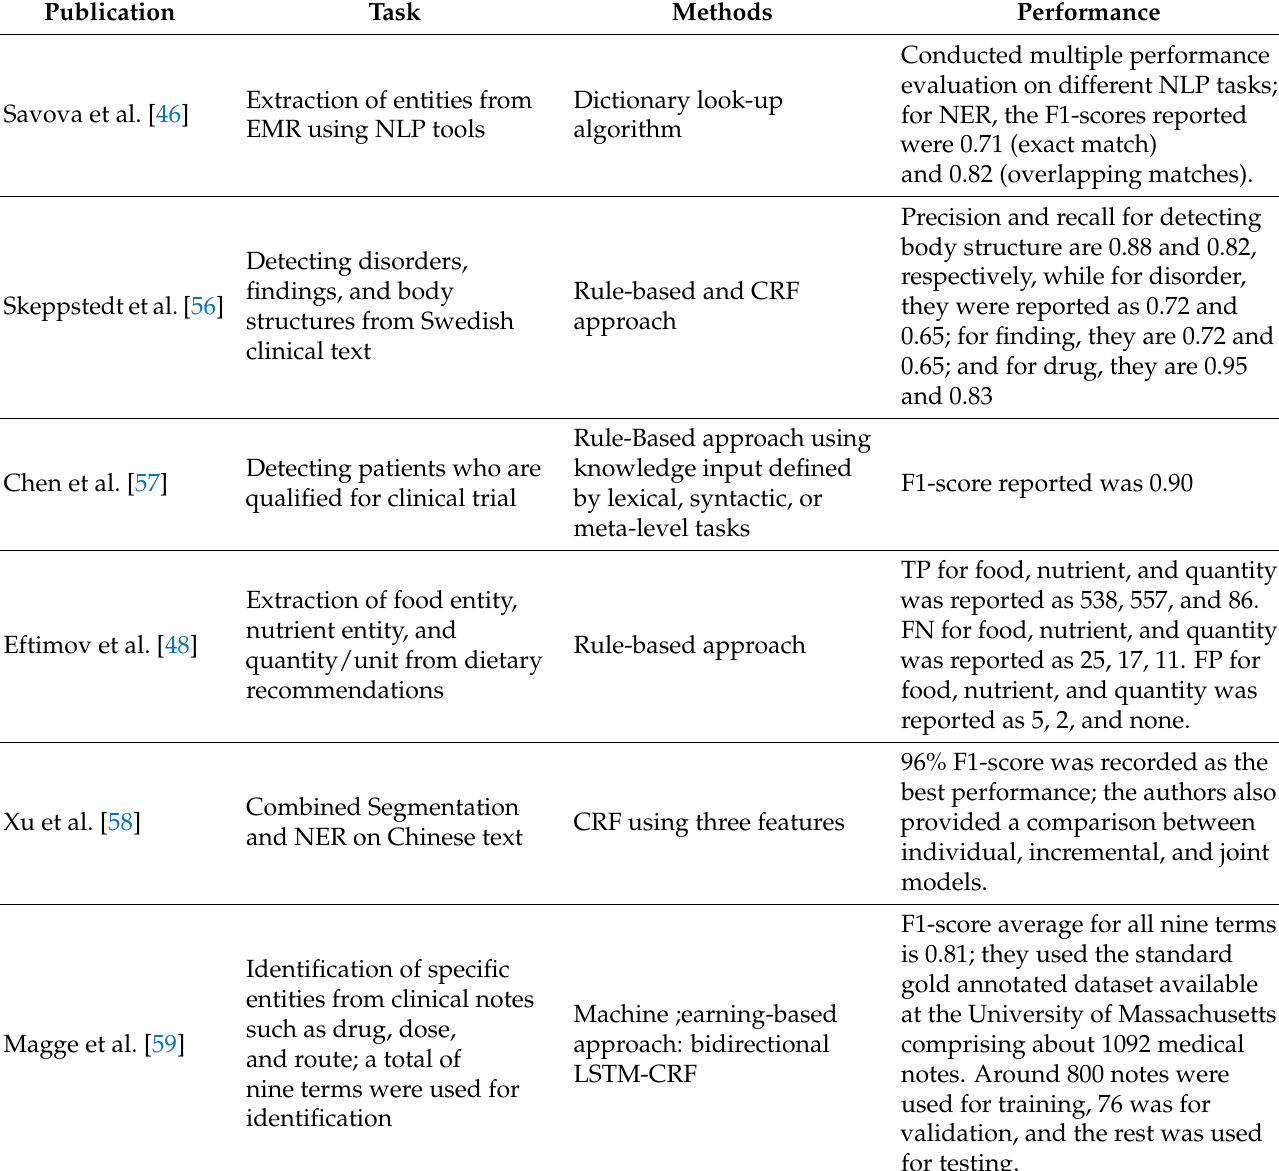
Table A1. Summary of previous works in clinical NER.